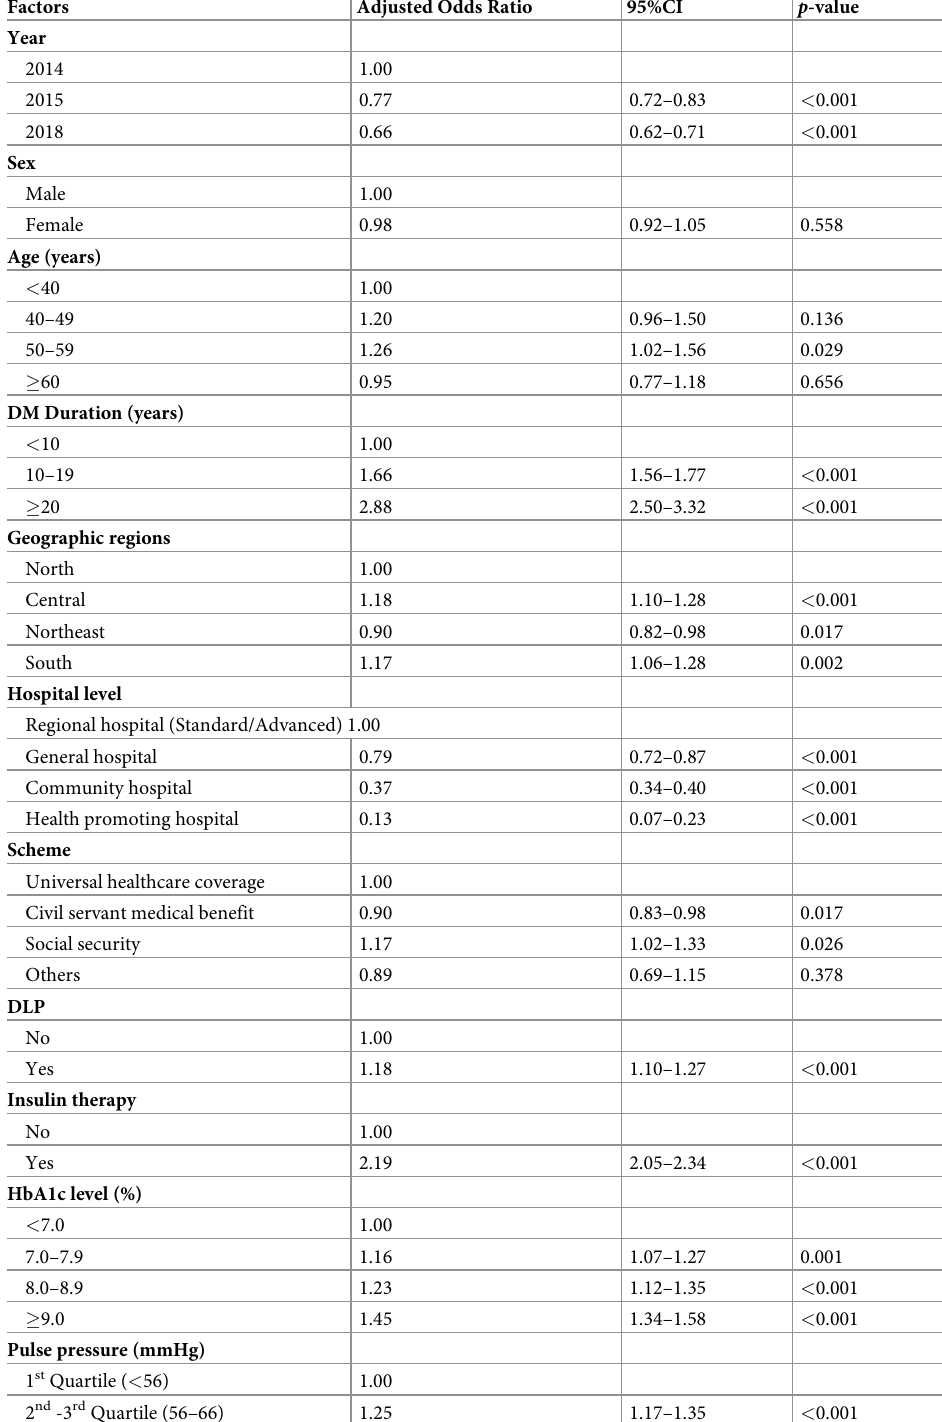
Table 4. Multivariate analysis for factors associated with diabetic retinopathy (DR) among Thai patients with T2D,